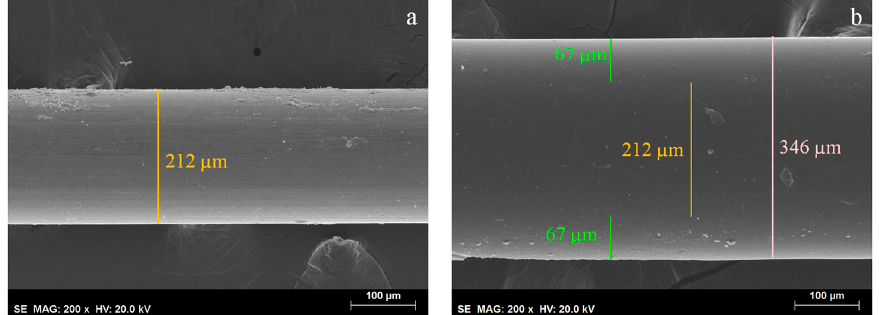
Figure 4. SEM images of: ( a ) untreated steel wire with a magnification of 200× (average outer diameter of 212 μ m); ( b ) steel wire coated with crosslinked poly(methyltetradecyl pyrrolidinium) TFSI with a magnification of 200× (average outer diameter of 346 μ m).